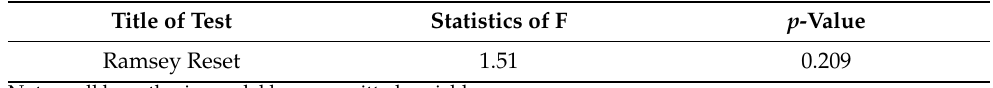
Table 16. The Specification test outcomes of the first